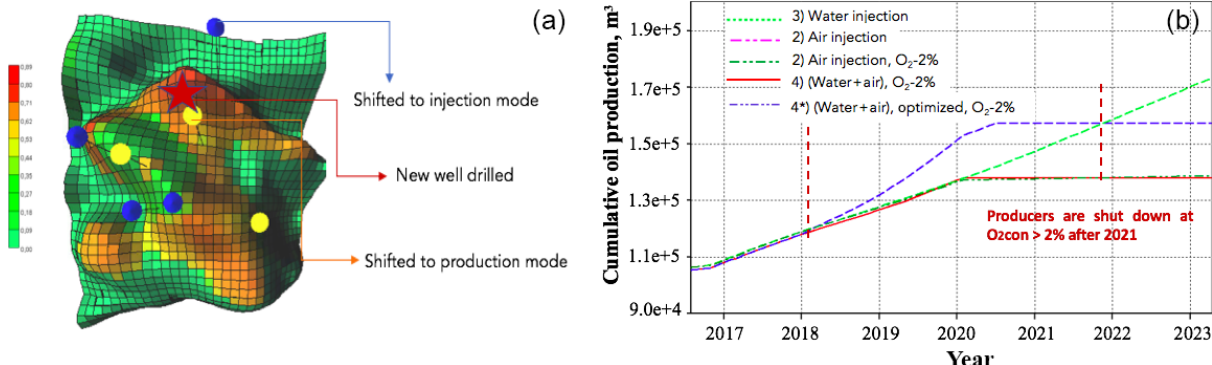
Figure 8. Optimization scenario (a) and cumulative oil production (b) for subsection three before air